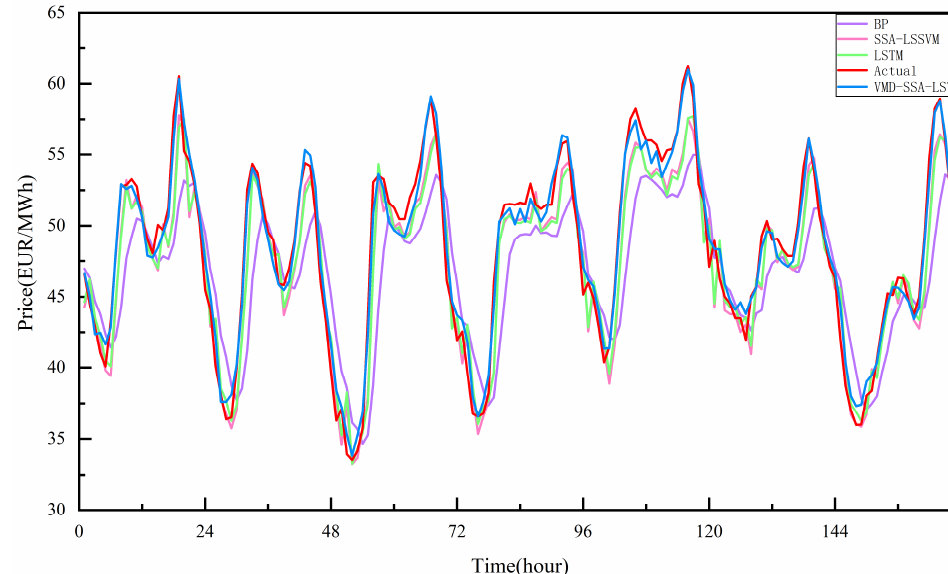
Figure 12. Curve of fall forecast results for Spain.